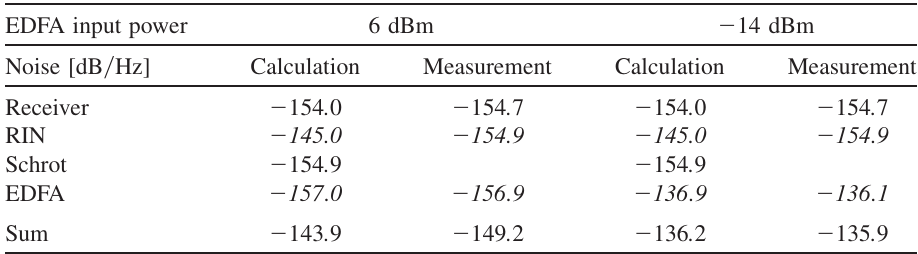
TABLE III. Noise in the transmission channels.